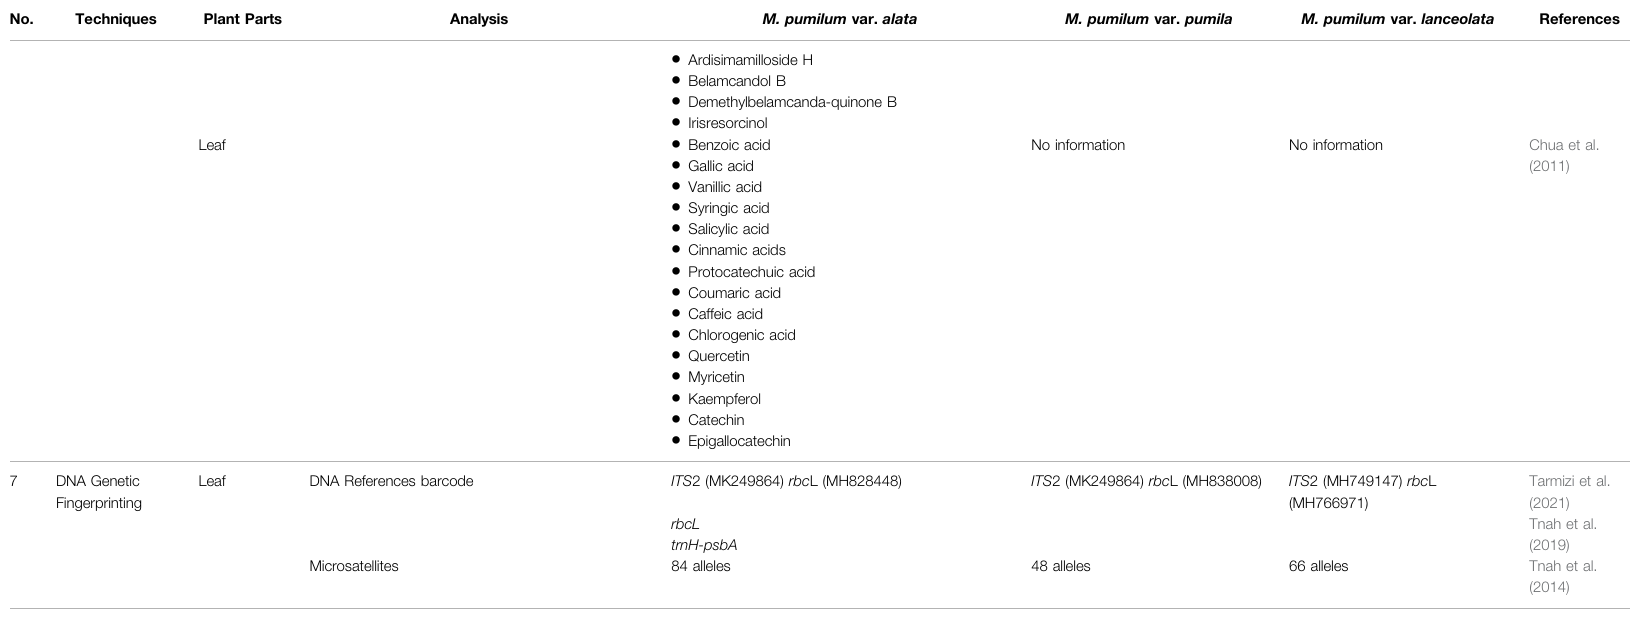
TABLE 2 | ( Continued ) Characteristic features to distinguish Marantodes pumilum varieties based on different analytical